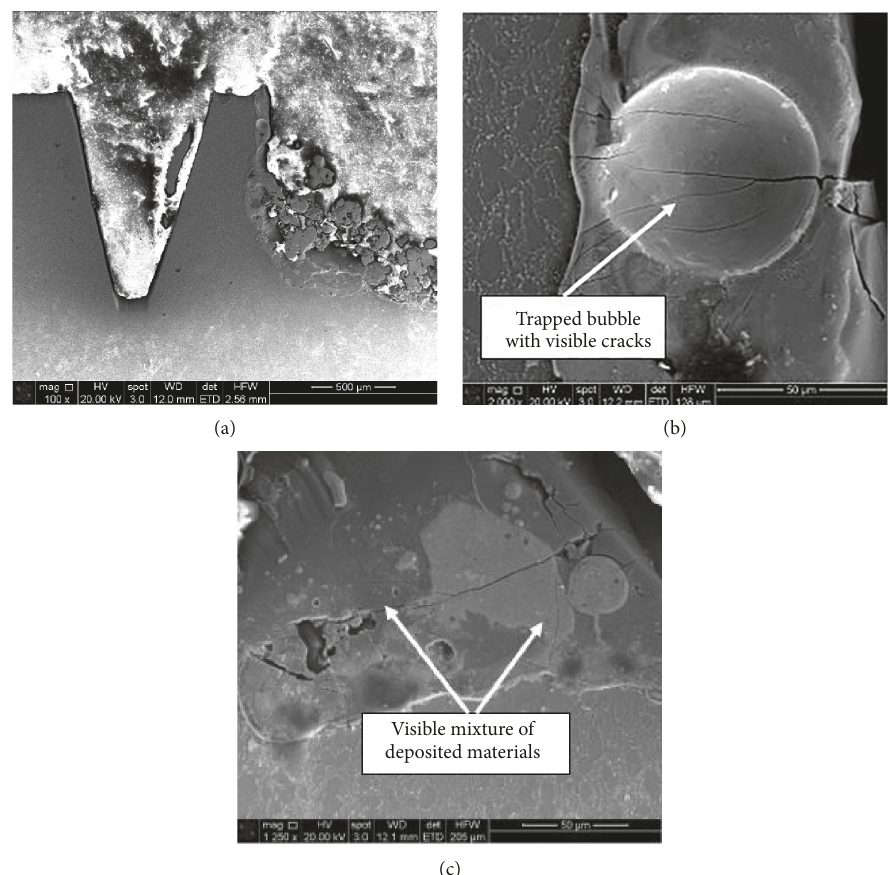
Figure 5: SEM micrographs of damaged Inconel threads of the parent material after stud